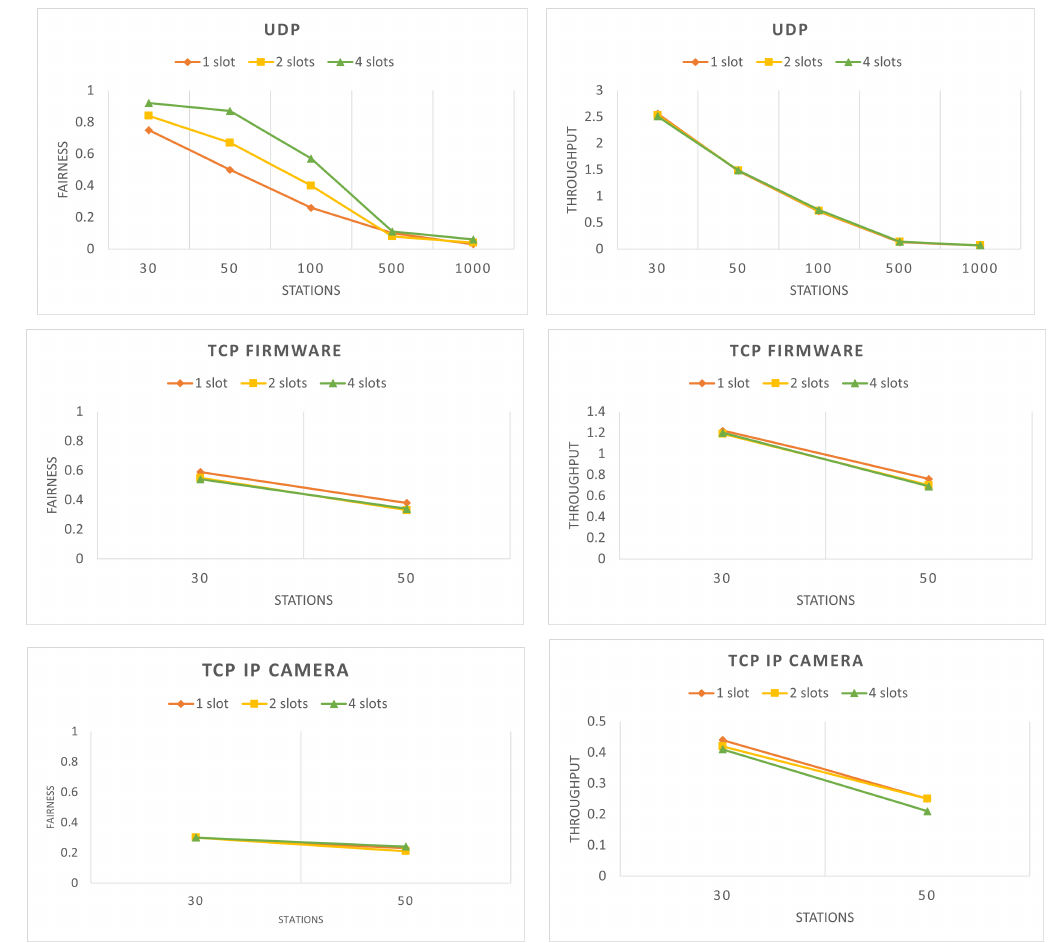
Figure 2. ( left ) Network fairness, ( right ) Network throughput (in Mbps)—in 60 s for different number of stations and RAW slots without introducing selfish stations.